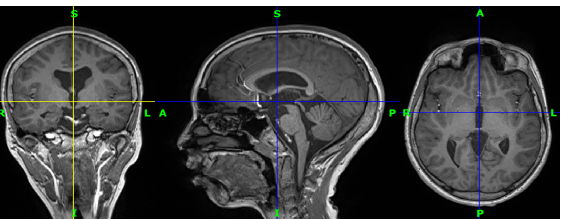
Figure 5. Three-dimensional T1-weighted MRI for a patient from the data set in coronal view, sagittal view, and axial view, respectively. R indicates the right of the brain, L indicates the left of the brain, S (superior) indicates the top of the body, and I (inferior) indicates the bottom of the body.